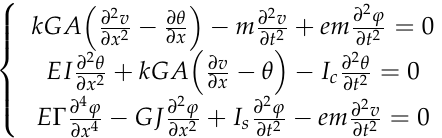
Figure 6. Segment of beam with arbitrary section and its coordinate system.